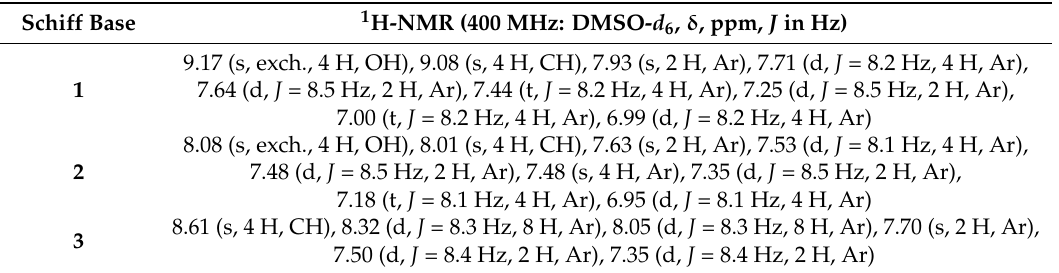
Table 3. 1 H-NMR spectral data for Schiff bases 1 – 3